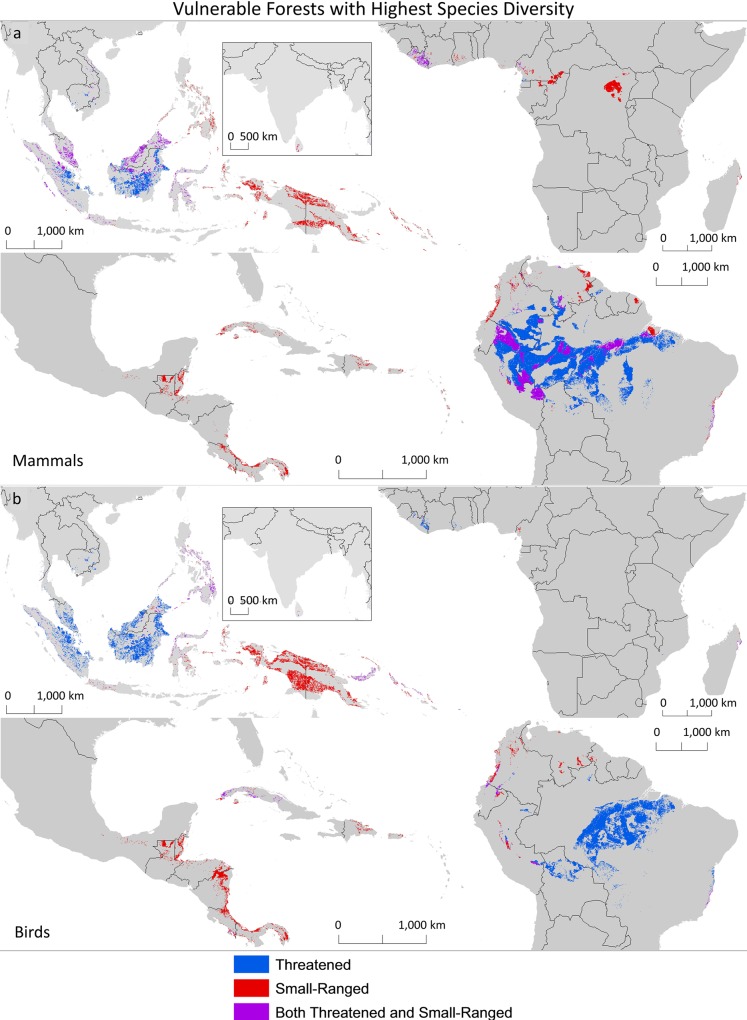
High biodiversity vulnerable forests.Vulnerable forest areas for (a) mammals and (b) birds within the 10 percent richest global land area for threatened (blue), small-ranged (red), or both (purple) mammal and bird species (Jenkins et al. 2013, Pimm et al. 2014).